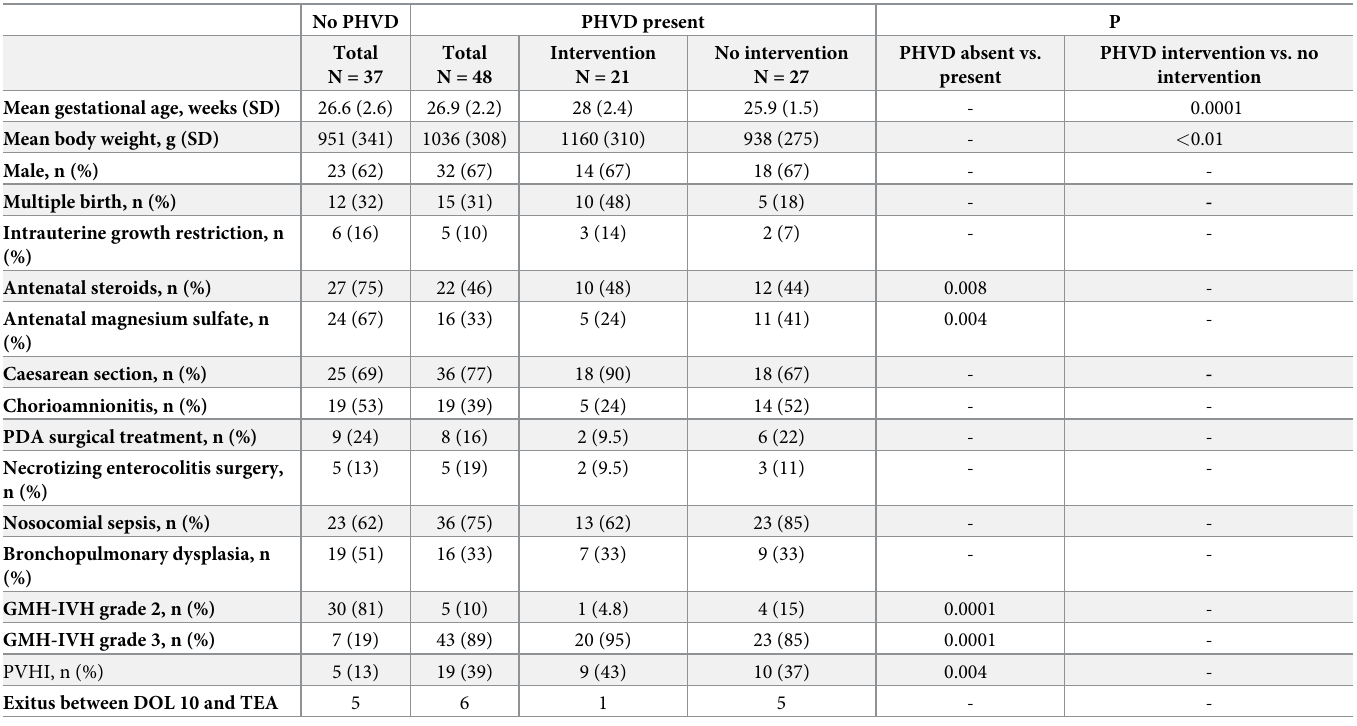
Table 1. Perinatal and neonatal clinical data by study group.